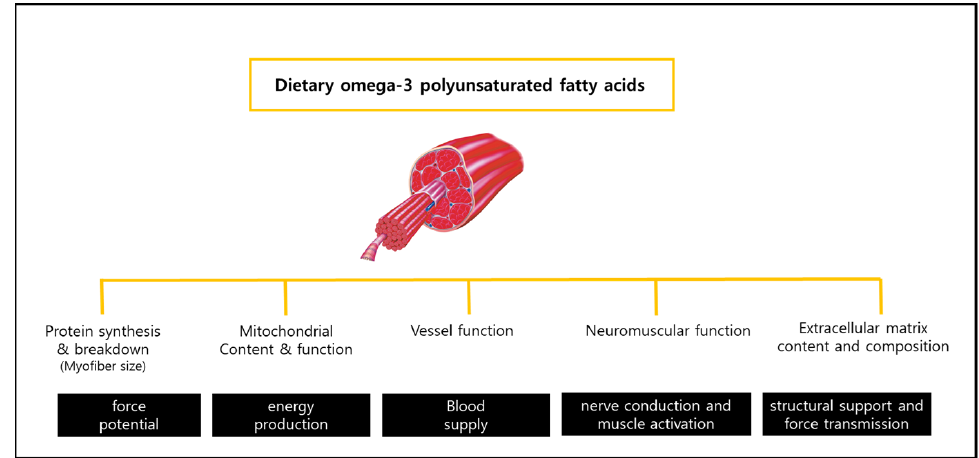
Figure 1. Potential effects of dietary omega-3 polyunsaturated fatty acids on muscle function. A loss of muscle function can occur even with short-term reduced use. A previous study reported marked muscle loss after 4 days of immobilization, regardless of age